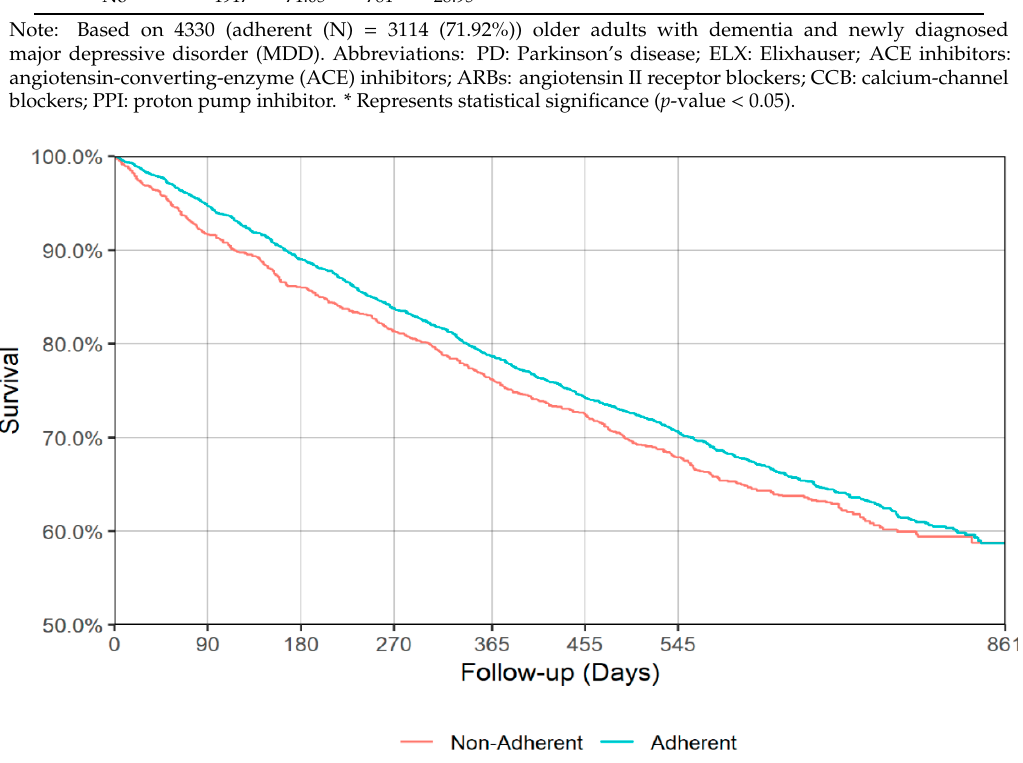
Figure 3. Inverse probability of treatment (IPT)-weighted Kaplan–Meier curve for all-cause mortality (acute phase). Weighted log-rank p = 0.168.